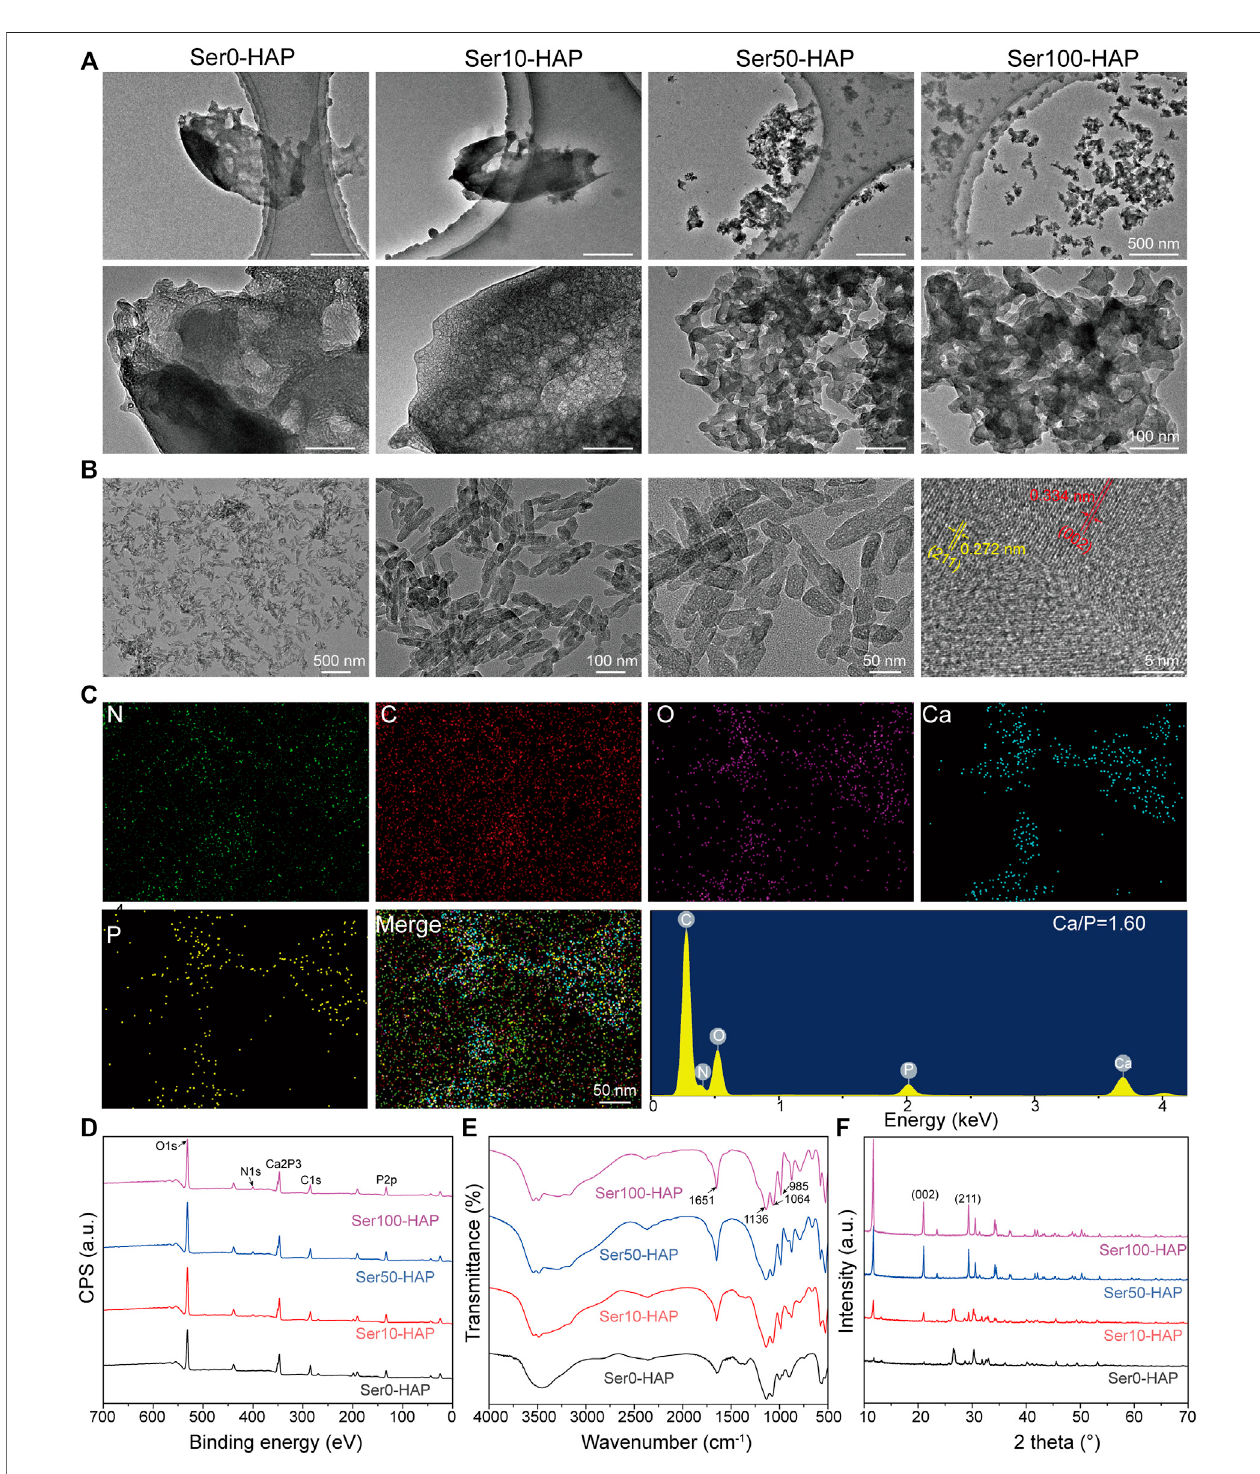
FIGURE 1 | Surface morphology and characterization of Ser-HAP. (A) TEM micrographs of Ser-HAP particles; (B) TEM and HRTEM images of Ser100-HAP particles; (C) EDS analysis of Ser100-HAP particles; (D) XPS spectra; (E) FTIR spectra; and (F) XRD patterns of Ser-HAP particles.